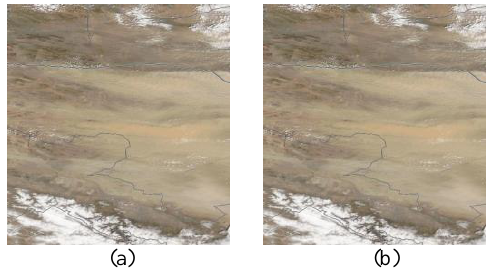
Figure 2. VIIRS Suomi NPP 1 km true-colour images on 3 May 2017: (a) Gobi Desert in Inner Mongolia; (b) Taklimakan Desert in the northwest